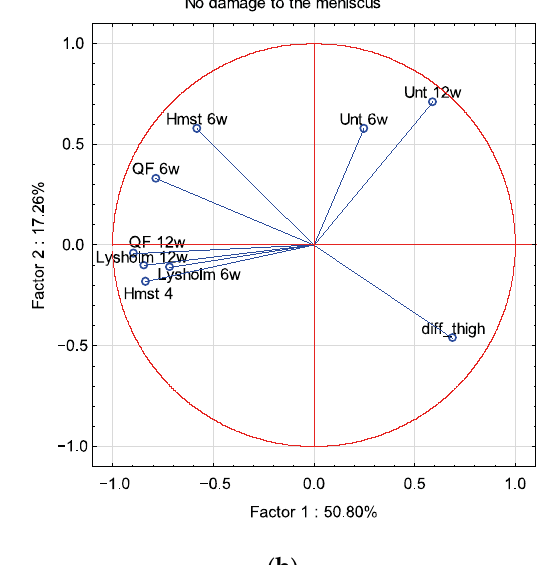
( b ) Figure 5. A graphic illustration of Principal Components Analysis of Lysholm, Unterberger test and muscle strength. Projection of the variables on the factor plane of the first two principal components for damage ( a ) and no damage ( b ) to the cartilage. 4. Discussion The study aimed to determine the impact of the effectiveness of surgical treatment along with the medical rehabilitation scheme on improving the stability and feeling of the deep knee joint and restoring the functional efficiency of the patient. We showed that the better treatment outcome was influenced by greater muscle strength and less thigh atro- phy. Moreover, we found that the poorer profound sensation negatively affected the Lysholm treatment outcome. A better preoperative Lysholm score was a guarantee of greater muscle strength at the end of the observation and better deep feeling. Body weight